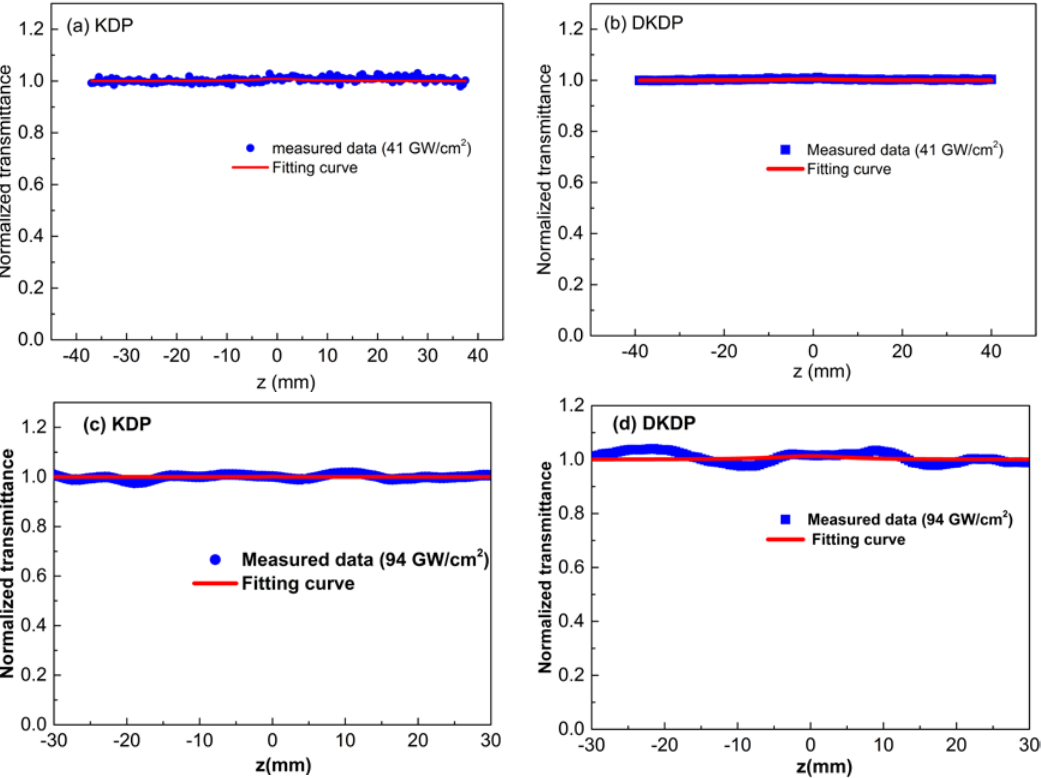
Figure 4. At λ = 1064 nm, open aperture Z-scan data and fitted curves of II-type for KDP and 70%-DKDP crystals under different laser intensities: ( a ) KDP under 41 GW/cm 2 , ( b ) DKDP under 41 GW/cm 2 , ( c ) KDP under 94 GW/cm 2 , ( d ) DKDP under 94 GW/cm 2 .